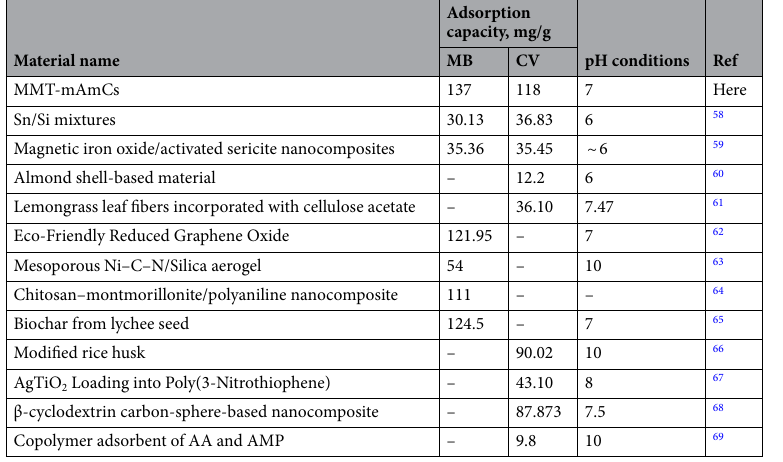
Table 1. Comparison between MMT-mAmCs composite and other adsorbents reported elsewhere, in terms of adsorption capacity (mg/g), and adsorption conditions toward MB&CV